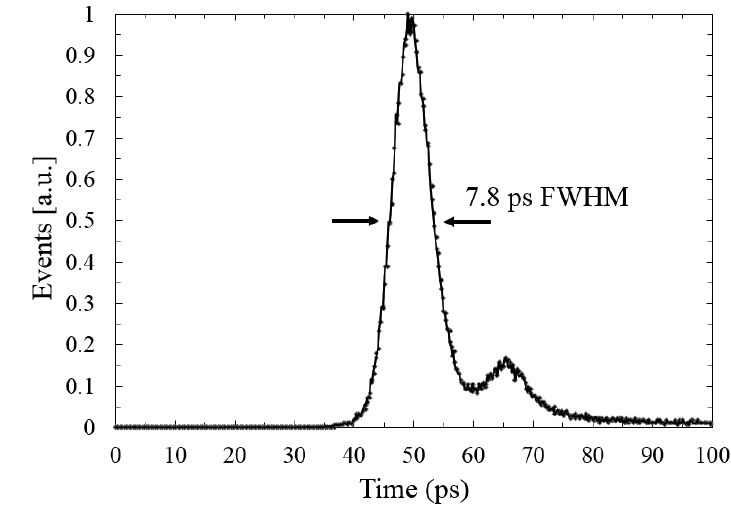
Figure 11. Histogram of the SPAD and QC SPTR at 1.75 V of excess voltage with a 100 mV threshold at a wavelength of 410 nm.